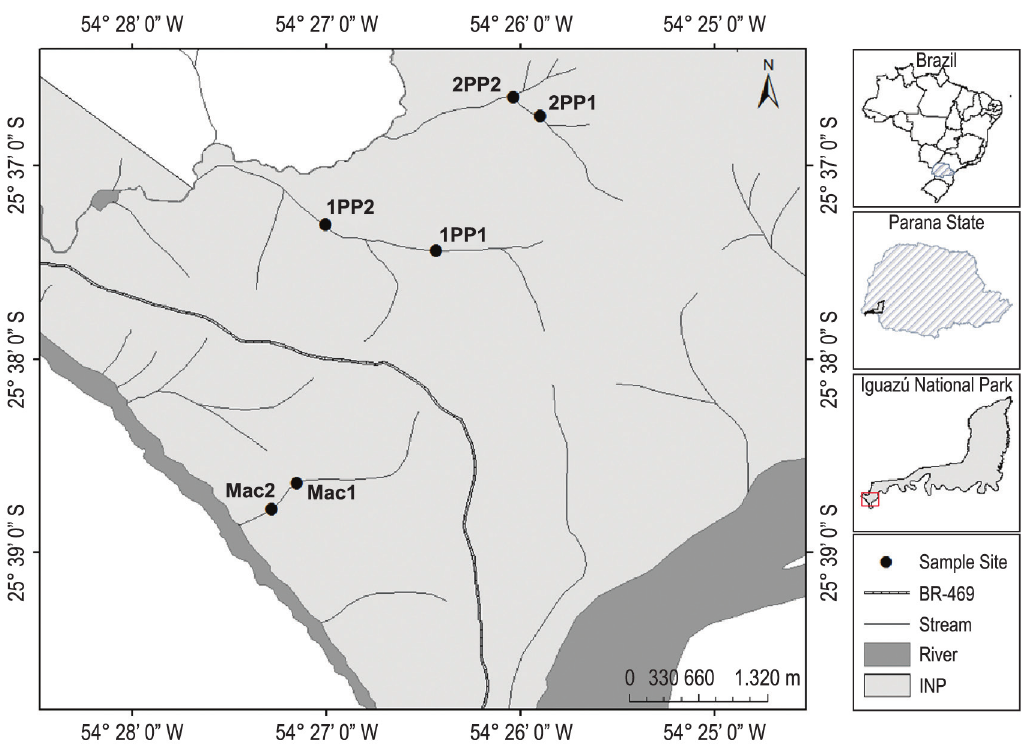
Figure 1. Location of the sampling sites in the Iguaçu National Park (INP). Mac1: stream of Macuco site 1; Mac2: stream of Macuco site 2; 1PP1: stream 1 of Poço Preto site 1; 1PP2: stream 1 of Poço Preto site 2; 2PP1: stream 2 of Poço Preto site 1; 2PP2A: stream 2 of Poço Preto site